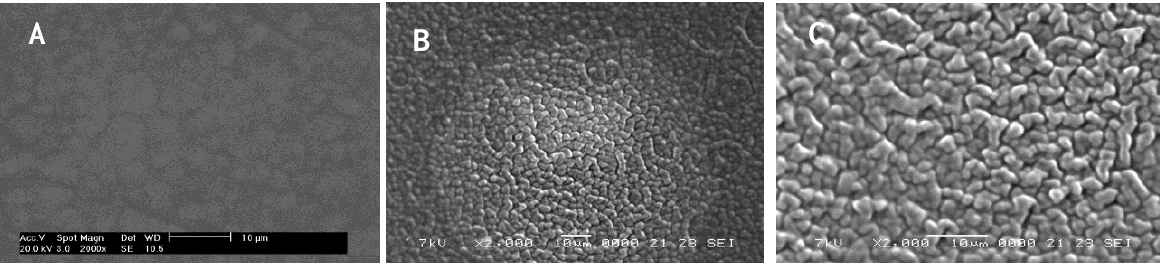
Figure 7. Scanning electron microscopy micrographs of the surfaces of the CMCR-immobilized membranes at the magnification of 2,000× ( A ) without ionophore, ( B ) with fresh membrane, and ( C ) with membrane employed for two months. B C